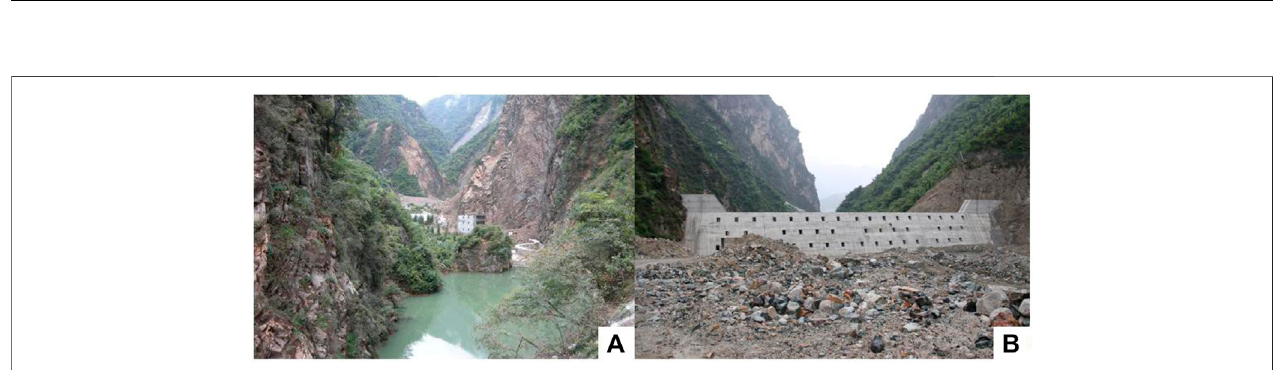
FIGURE 8 | (A) Dammed lake formed by the earthquake and (B) arti fi cial dam in the catchment.